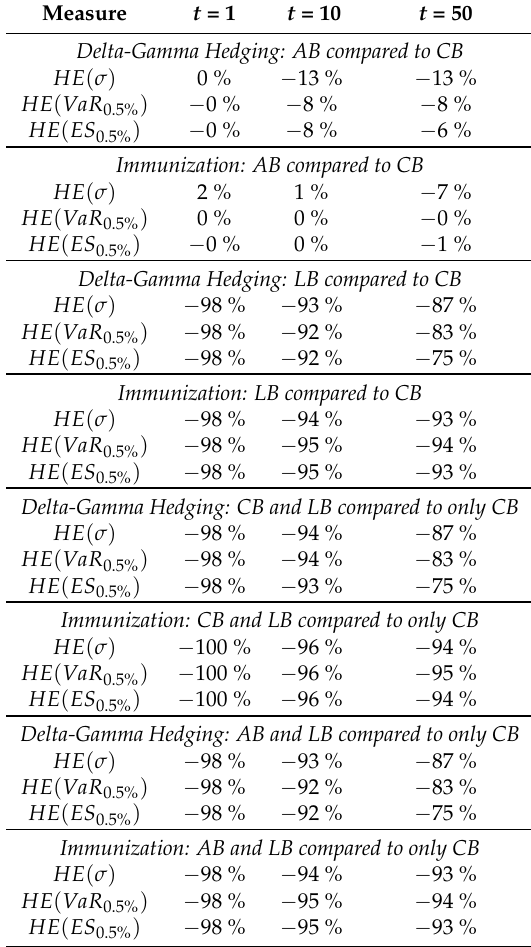
Table 17. Risk Reduction Measures—Comparison of Bond